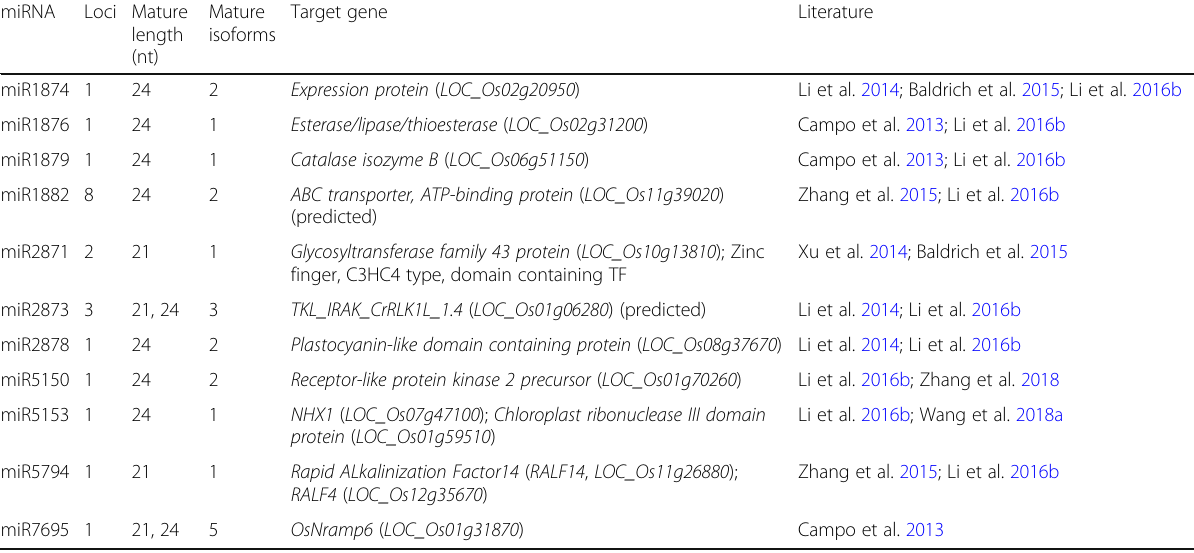
Table 1 miRNAs responsive to Magnaporthe oryzae or its elicitors a (Continued) miRNA Loci Mature